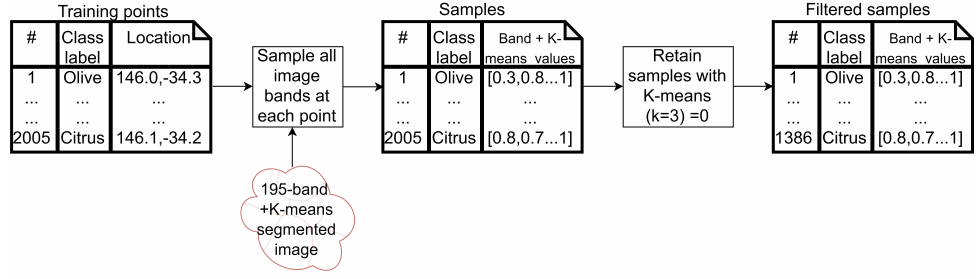
Figure 6. Generating band samples from training data and filtering samples to include only those belonging to points with evergreen or summer